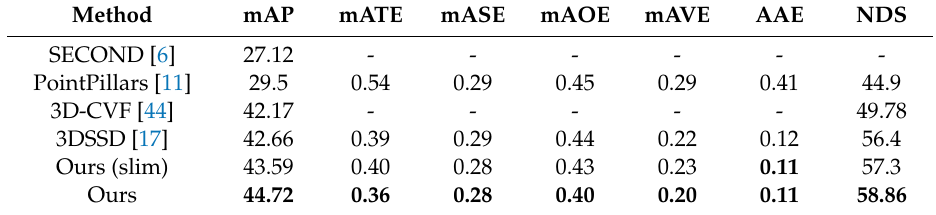
Table A2. Comparison of the 3D object detection performance of KDA3D with state-of-the-art 3D object detectors: mean Average Precision (mAP) and nuScenes detection score (NDS) on nuScenes’s val set.